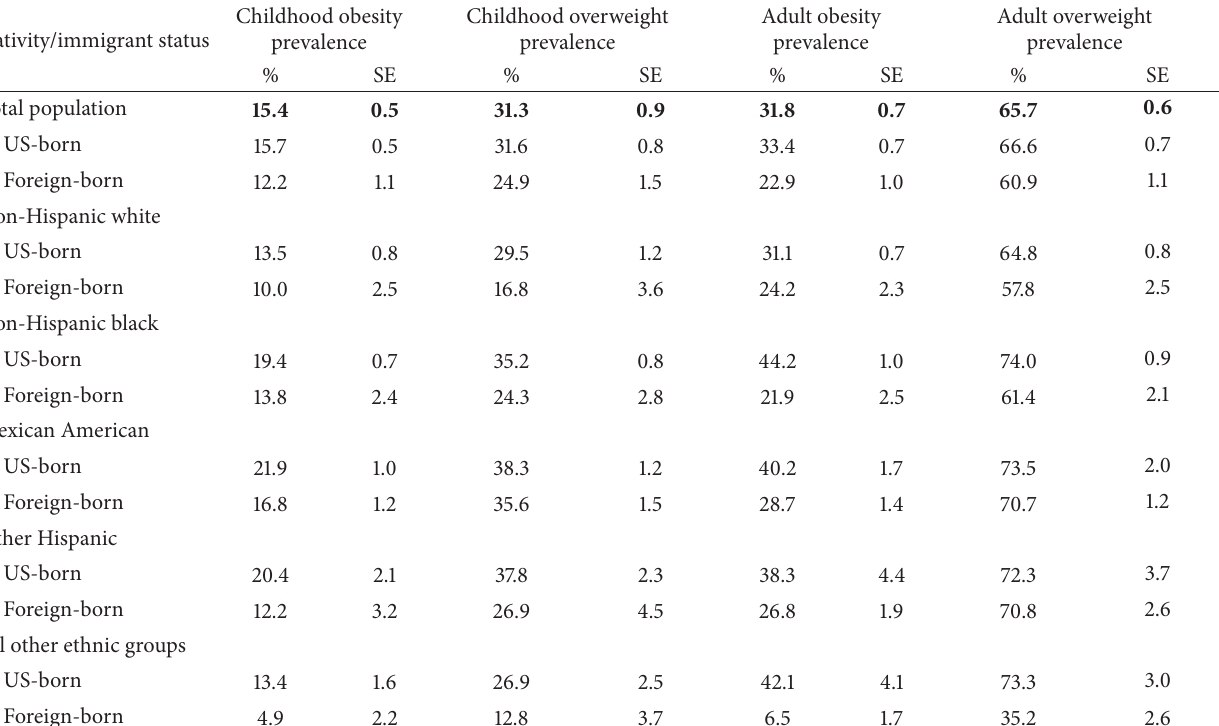
Table 7: Obesity and overweight prevalence (weighted) among US children and adolescents aged 2–19 years ( 𝑁 = 16, 717 ) and adults